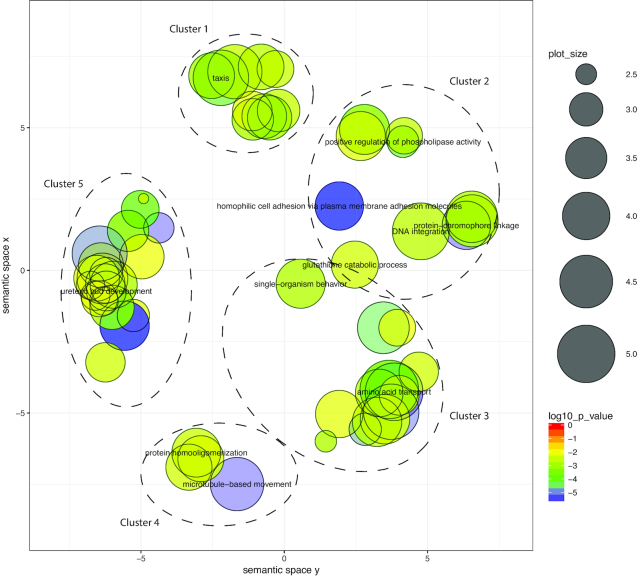
Gene ontology biological processes over-enriched within Cnidaria-specific orthogroups visualized using ReViGO. Over-representation analysis was performed with ClusterProfiler, with a P-adjusted cutoff of 0.01. Color indicates log10-transformed P-adjusted value. Terms are plotted within an x-y semantic space, in which similar terms are clustered within closer proximities. Color indicates P-value and circle size indicates frequency of GO term in the Cassiopea database.